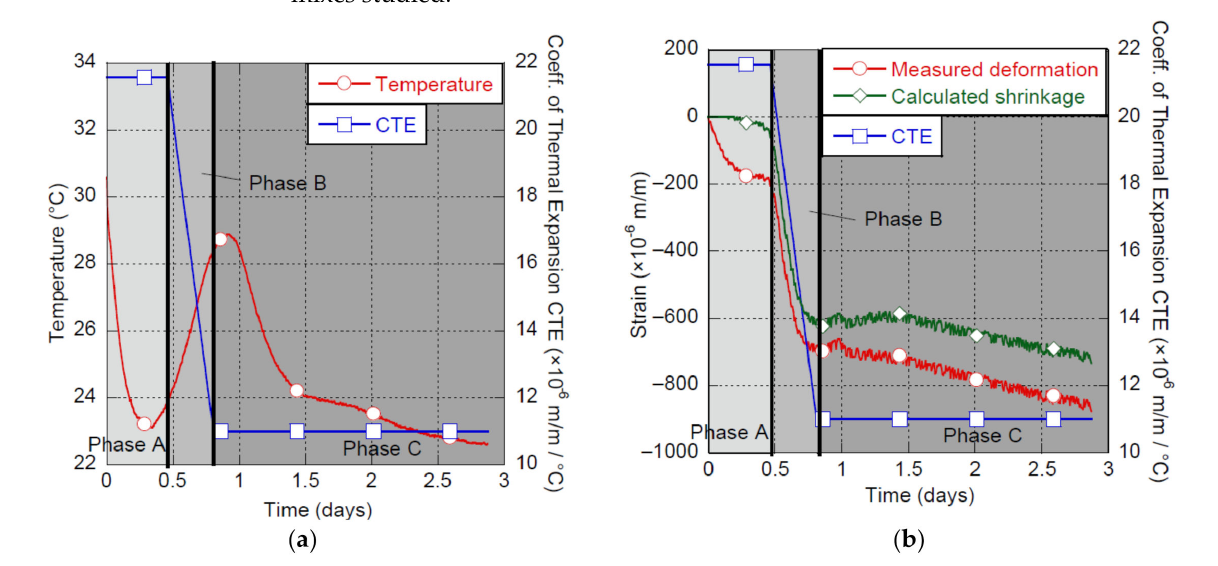
Figure 2. Early-age behavior of the UHPC-F3%, ( a ) temperature and CTE vs. time, ( b ) shrinkage and CTE vs.